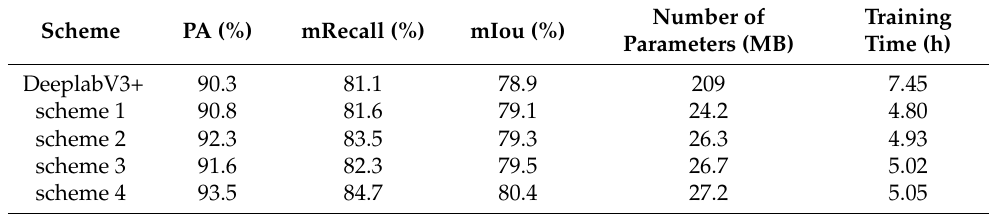
Table 4. Ablation experiment